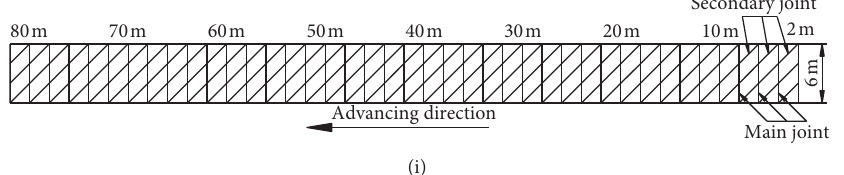
Figure 15: Model section of joints with different parameters in a coal seam. (a) Model A. (b) Model B. (c) Model C. (d) Model D. (e) Model E. (f) Model F. (g) Model G. (h) Model H. (i) Model I.